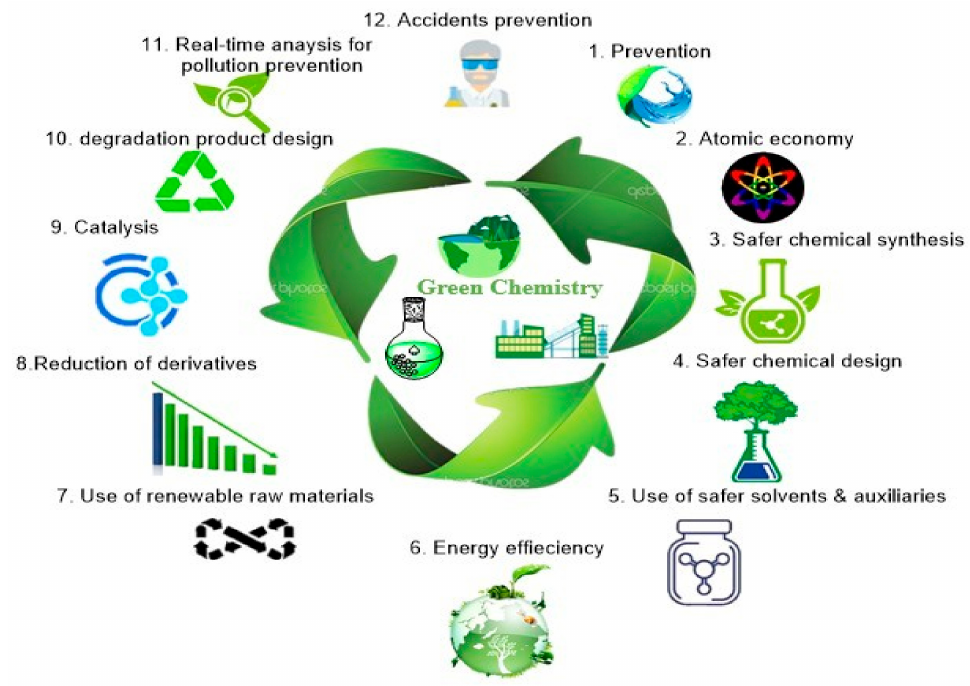
Figure 2. Warner’s principles of green